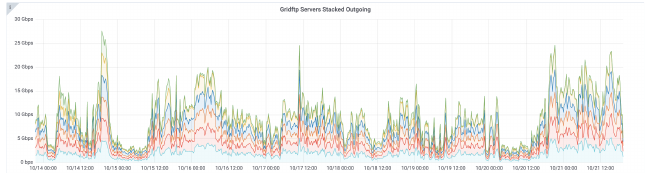
Figure 4. Network usage of production of six GridFTP servers at UCSD